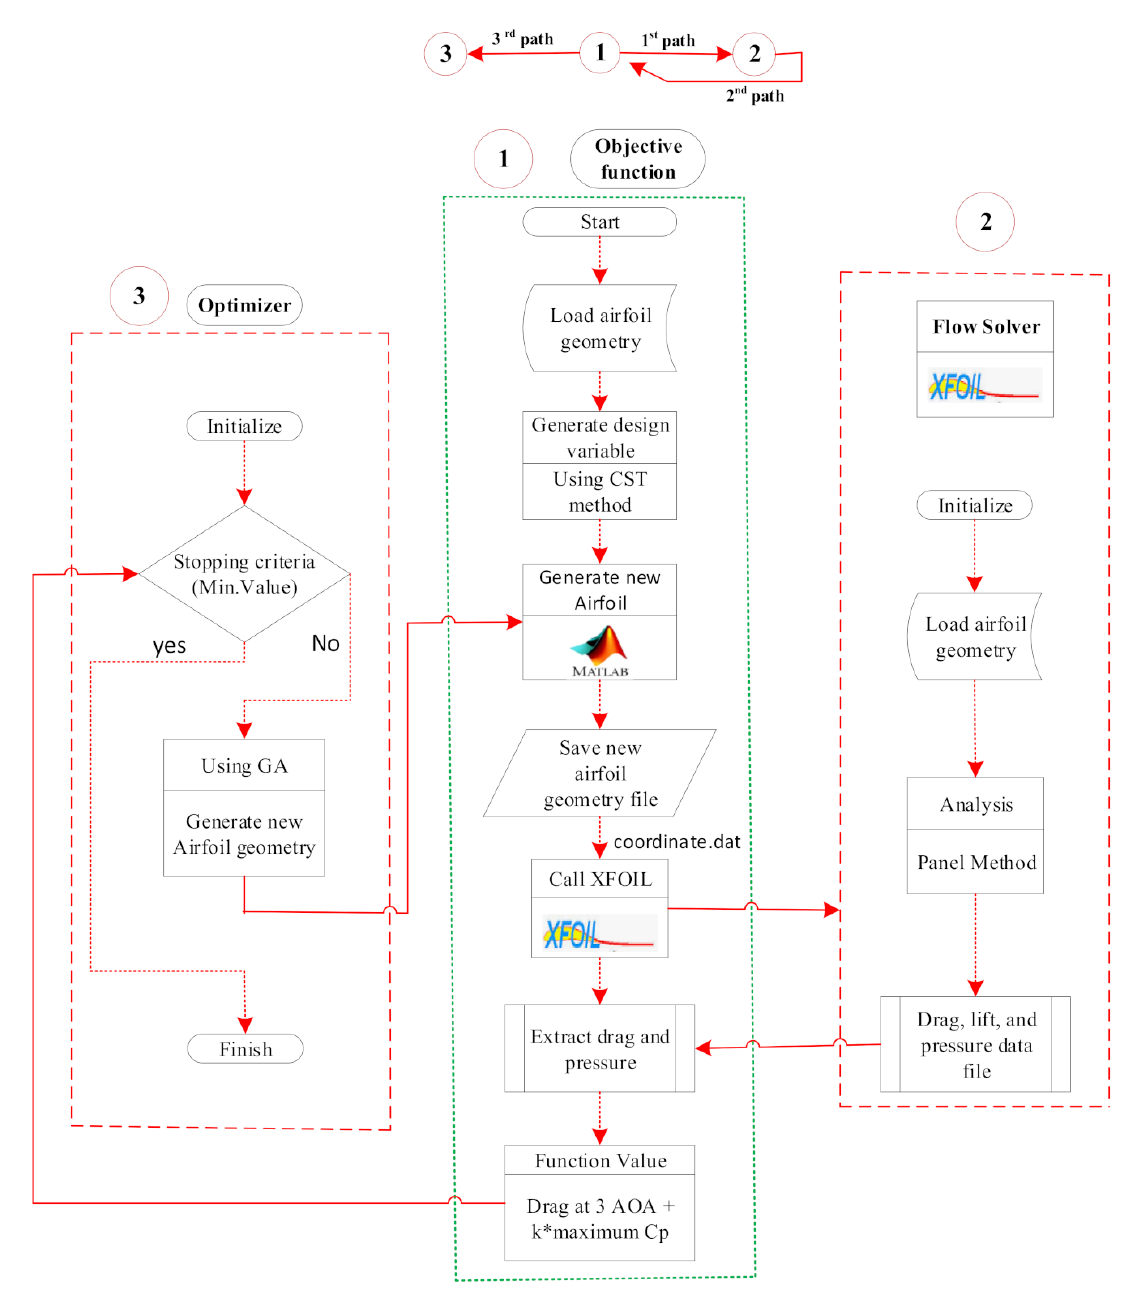
Figure 5. Optimization flow